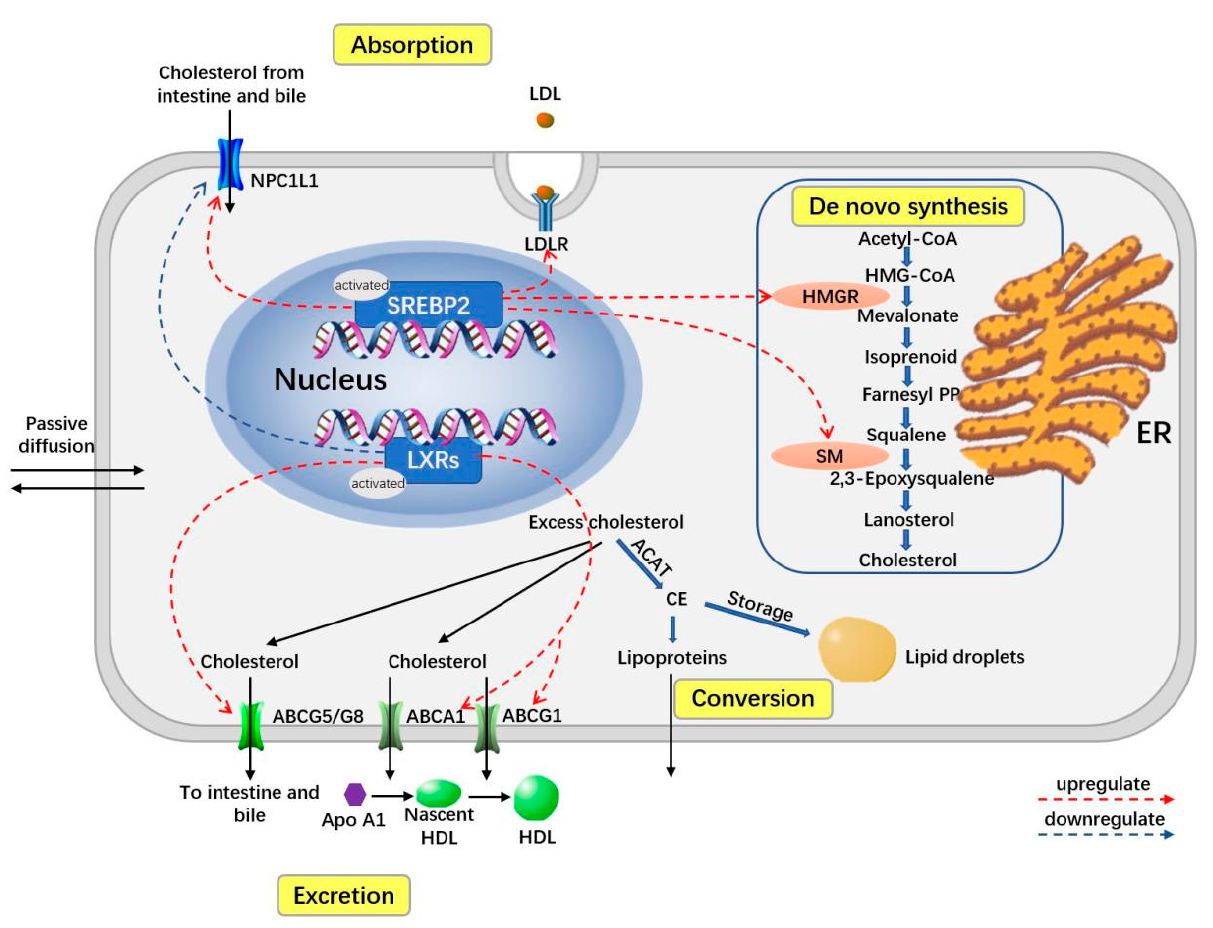
Figure 2. Major pathways of cellular cholesterol homeostasis.